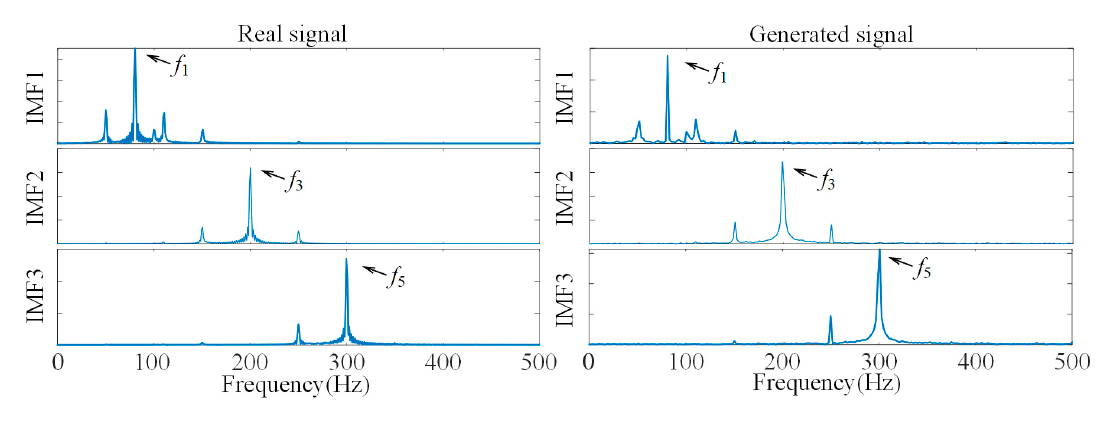
Figure 4. Comparison of real signal and generated signal.